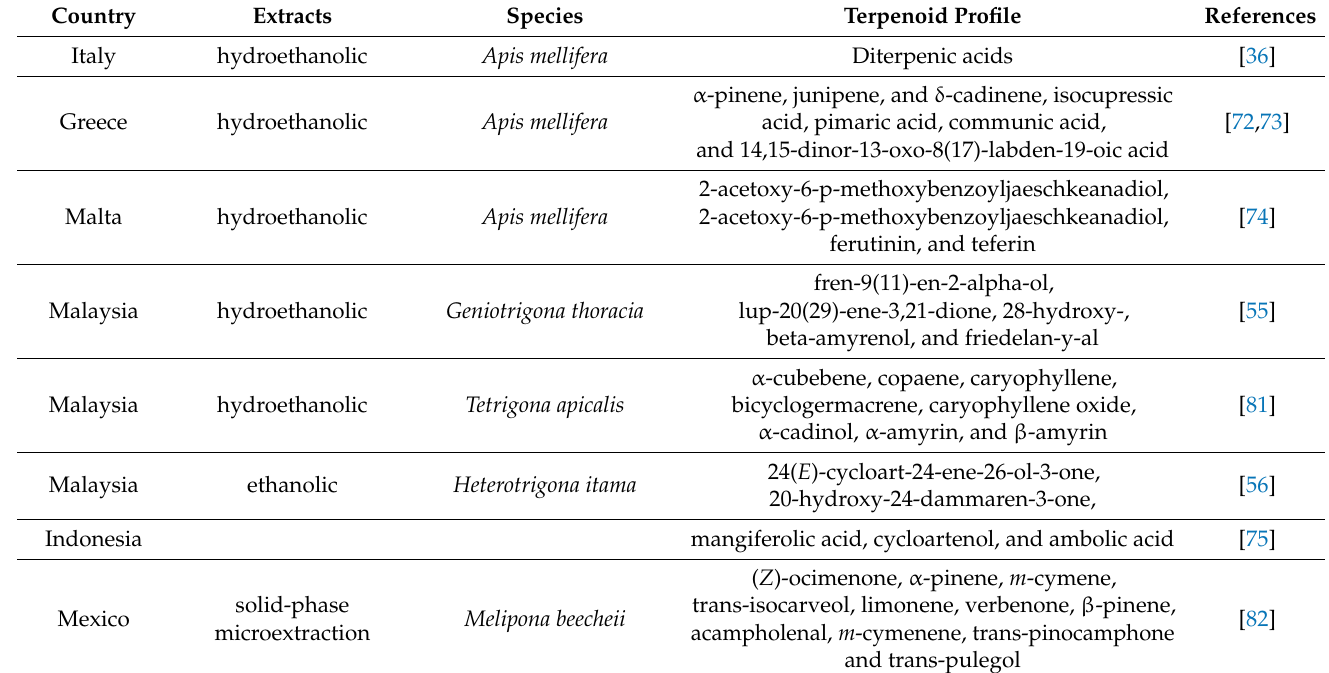
Table 2. The profile of terpenoids of propolis from various sources. These are for illustrative purposes only and by no means